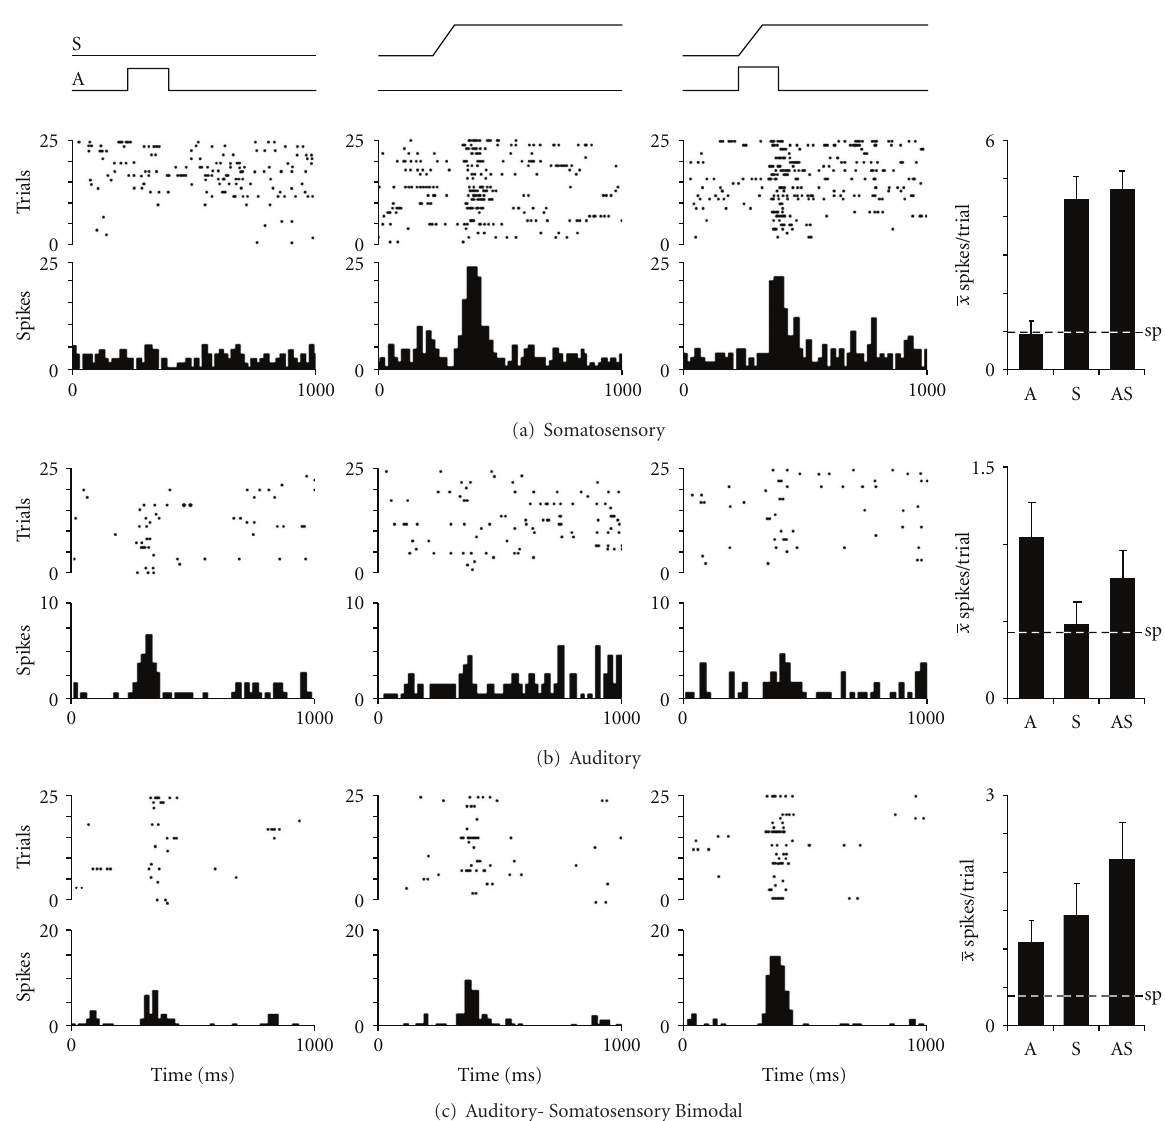
Figure 3: Sensory responses of neurons from core auditory cortex of ferrets with early hearing impairment. Single-unit recordings revealed that neurons were responsive to auditory (square wave, white noise), somatosensory (ramp; 1g filament displacement of skin/hair) or combined auditory-somatosensory stimulation as displayed in the raster/histogram rows. In (a), the neuron was unresponsive to the auditory stimulus, but was vigorously activated by the somatosensory cue, and this response was not significantly altered when the two stimuli were combined. These responses are summarized by the bar graph (far right; error = standard error; sp = spontaneous activity), and are characteristic of a unisensory somatosensory neuron. The same conventions are used in the subsequent rows where activity indicative of a neuron with unisensory auditory properties (b) and a neuron with bimodal auditory-somatosensory response features (c) are illustrated. None of the depicted responses to combined stimulation were significantly (paired t -test) di ff erent from their best unisensory responses. These data show that core auditory cortical neurons in these hearing-impaired animals exhibit vigorous somatosensory-evoked